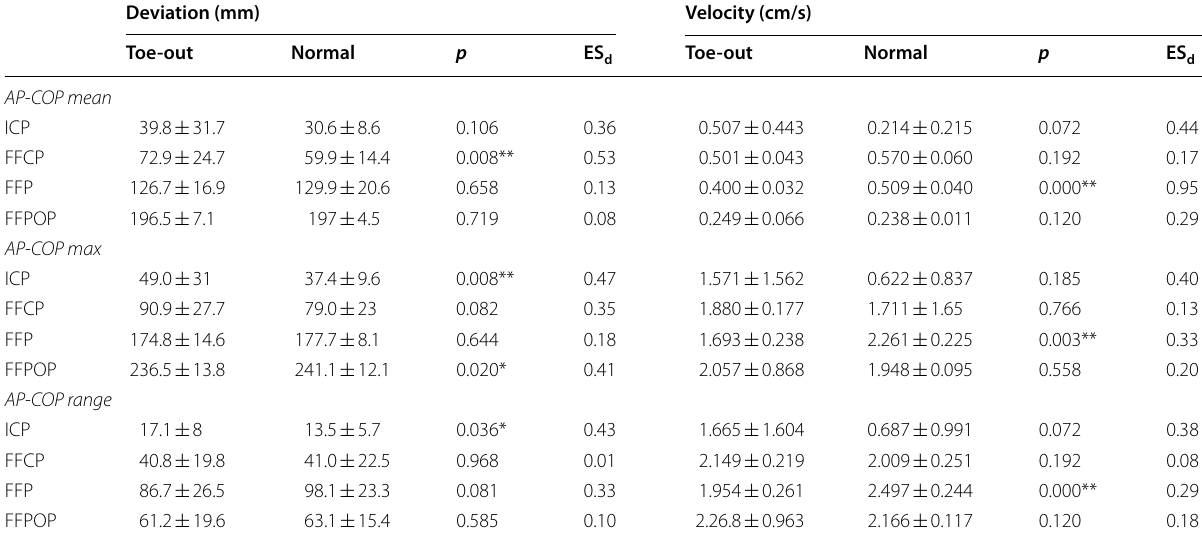
Values are expressed as mean standard deviation. ML-COP: COP in medial–lateral direction; AP-COP: COP in anterior–posterior direction ±